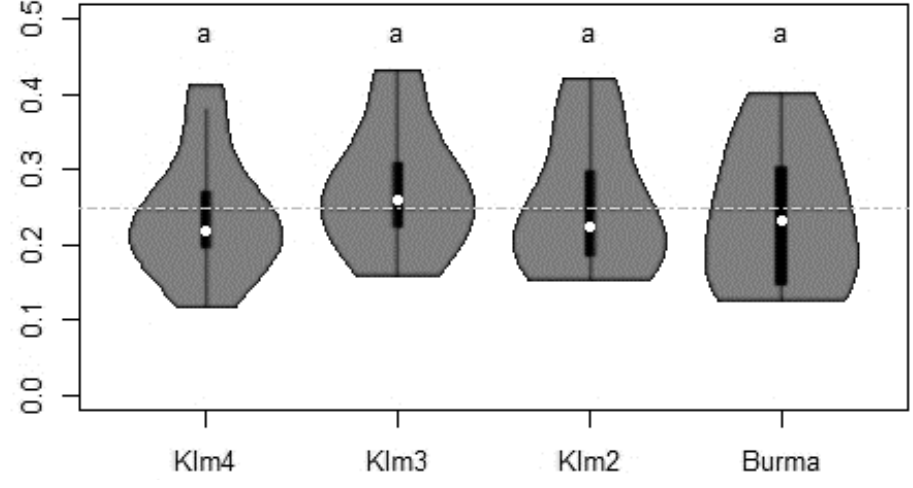
Figure 3. Proportions of stable flies captured by di ff erent blue screens during the experiment 1 (26 July to 12 August). The total numbers of stable flies caught per trap were: 30,476 (KLM2); 34,107 (KLM3); 30,298 (KLM4) and 30,523 (Burma). Inside each «violin plot», the white dot represents the median, the black vertical bar represents the first quartile below, the third quartile above. The lower and upper adjacent values (black line stretched from the bar = whiskers) are defined, respectively, as: the first quartile − 1.5 × interquartile and the third quartile + 1.5 × interquartile. The shape around the outside is the sampling distribution using a kernel estimator (density plot of the variable). When it is large, there are more data at this value. A horizontal grey line at 0.25 has been